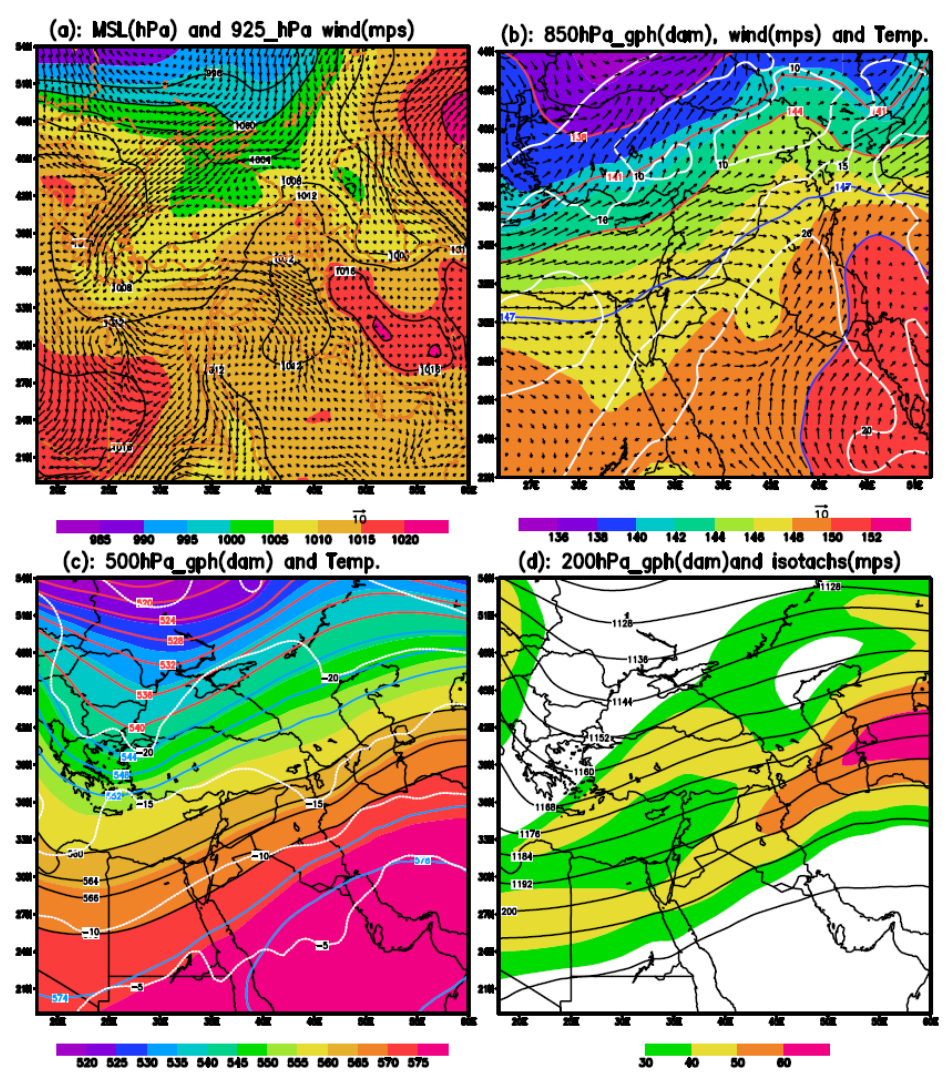
Figure A4. Same as Figure 10 but for 00 UTC 29 October 2017. At 00 UTC on 30 October 2017, a low solid pressure system was located over